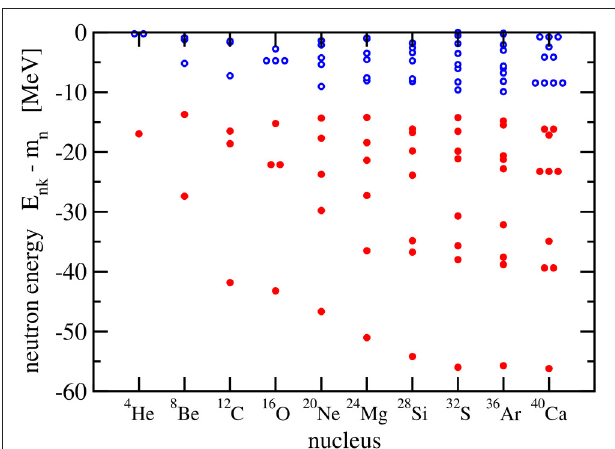
FIGURE 6 | Neutron levels in the self-conjugated even-even nuclei 4 He - 40 Ca. Occupied levels (with two neutrons) are denoted by a full red circle and unoccupied levels by an open blue circle.